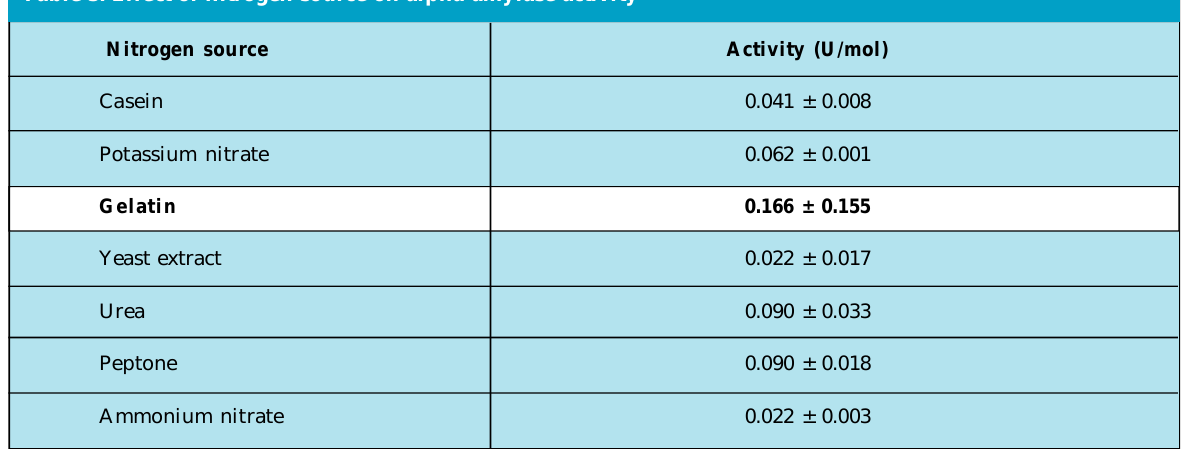
Table 3: Effect of nitrogen source on alpha amylase